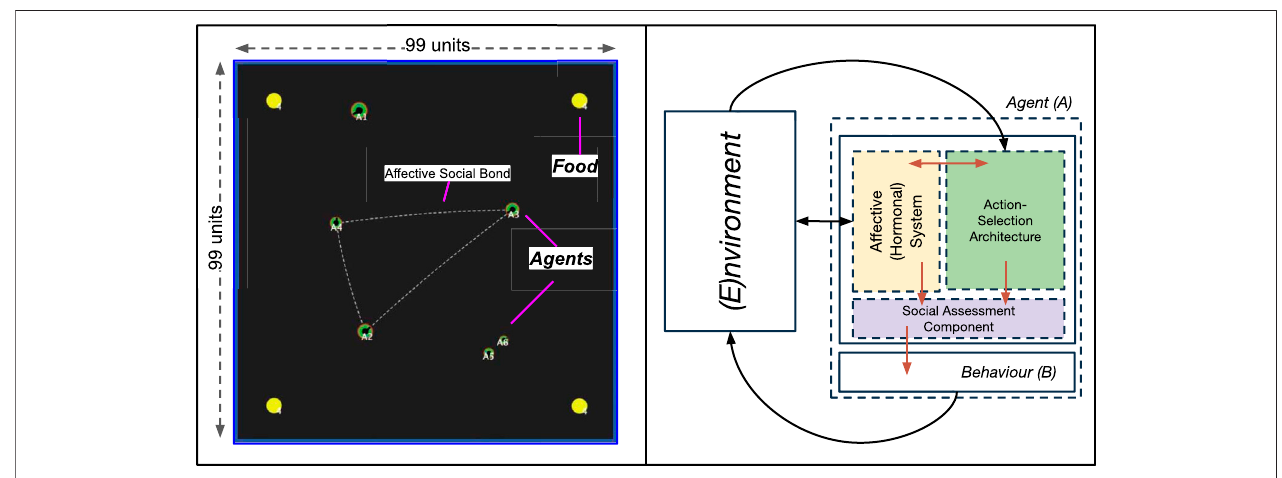
FIGURE2| Left:Ascreenshot ofoursimulatedenvironment,consisting oftwotypesofresources: Food (yellowspheres)and Agents(greendiscs).Thedottedline between agents indicates agents that share an affective social bond. The size of agents visually represents their social status (rank). Right: A top-level view of the components of the embodied agent model, with arrows indicating interactions between different components. These are described further in Section 2.2.1 ).